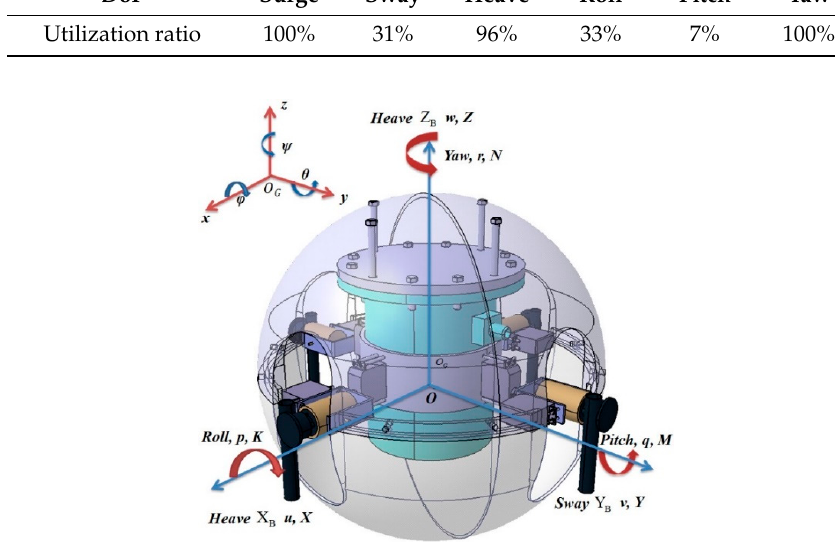
Figure 10. DoFs of SURIII.